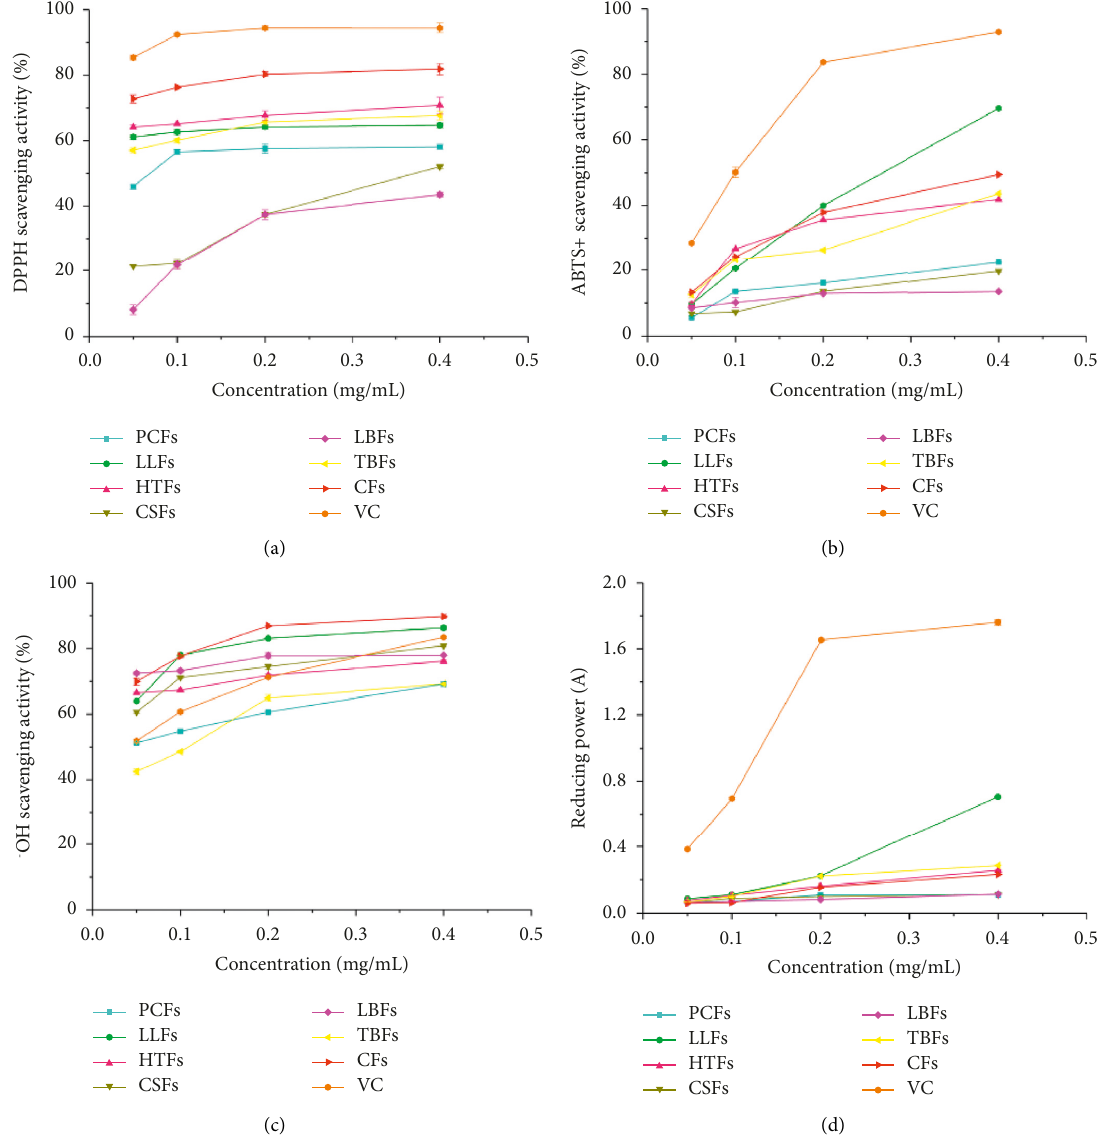
Figure 2: Antioxidant activities of CFs, PCFs, LLFs, HTFs, CSFs, LBFs, TBFs, and VC. DPPH radical scavenging ability (a), ABTS radical scavenging ability (b), hydroxyl radical scavenging ability (c), and reducing power